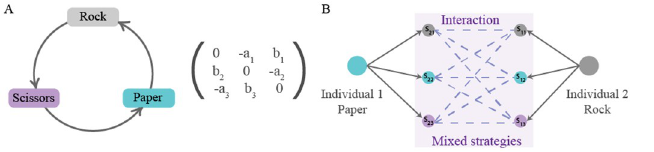
Fig 1. A schematic representation of behavioural mistakes in a rock-paper-scissors game. (A) Rock-paper-scissors dynamics with pure strategies is described by a fitness matrix such that the cyclic relationship between the three strategies is promoted. (B) The effect of execution errors on the example of one interaction: here individual 1 has chosen strategy paper and individual 2 has chosen strategy rock. Without mistakes, individual 1 would win this instance of the contest. However, a mistake in the execution leads to mixed strategies being played for both individuals resulting in different possible outcomes of the interaction. Hence, the outcome of the game is no longer deterministic but stochastic and depends on the probability distribution of